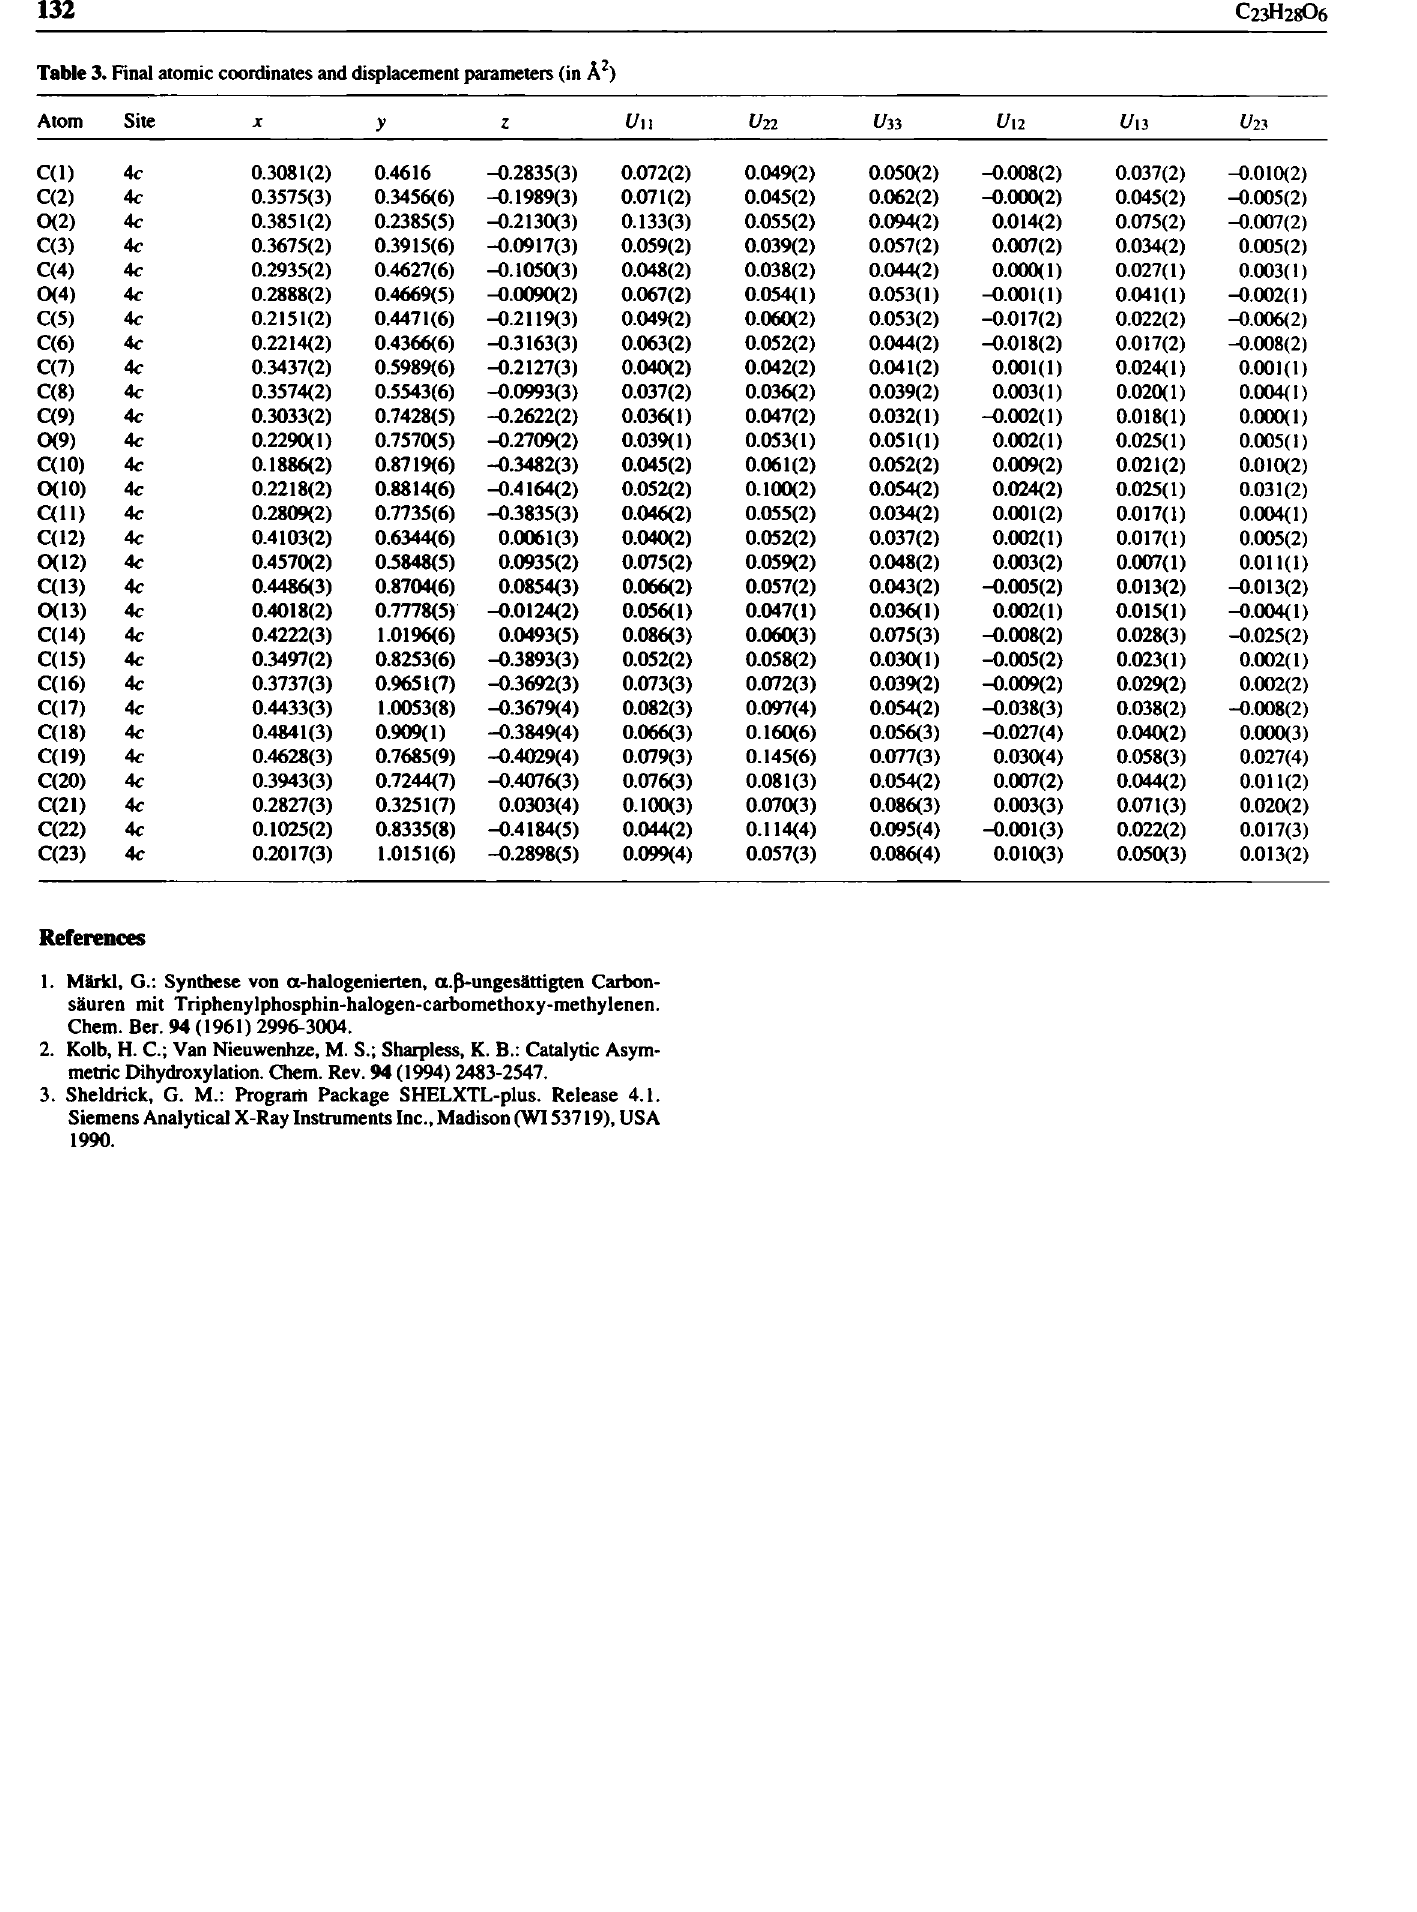
Table 3. Final atomic coordinates and displacement parameters (in À 2 )